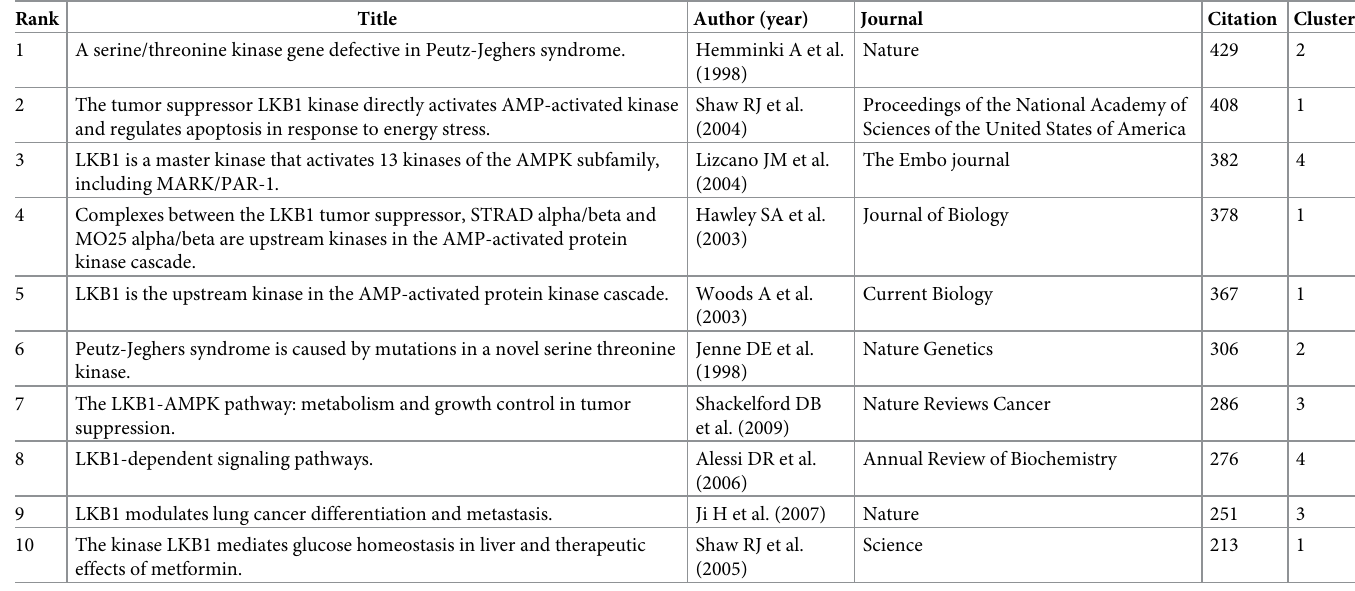
Table 5. Top 10 co-cited references in LKB1 research from 2000 to 2021.